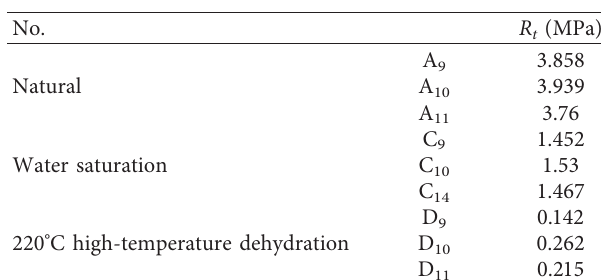
Table 3: Tensile strength of remolded sample of high-strength gypsum